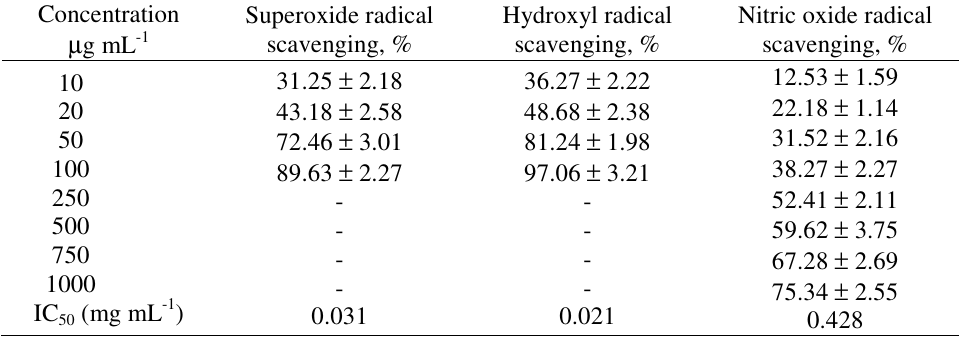
Table 1. Radical scavenging activity of ethanol extract of Cyperus rotundus rhizomes at different